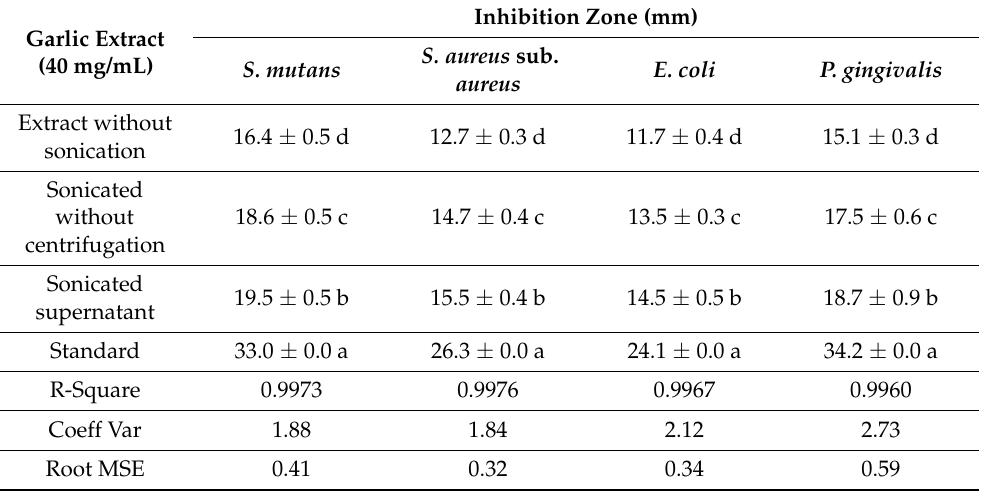
Table 3. Antibacterial activity of 40 mg/mL garlic extracts treated in different conditions by agar disk diffusion